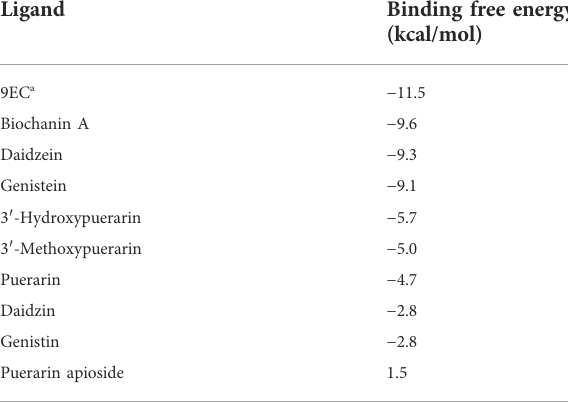
TABLE 3 Binding af fi nities (logarithm) of major components in Gegen water extract to the binding pocket of M3 receptor (PDB ID 5ZHP chain